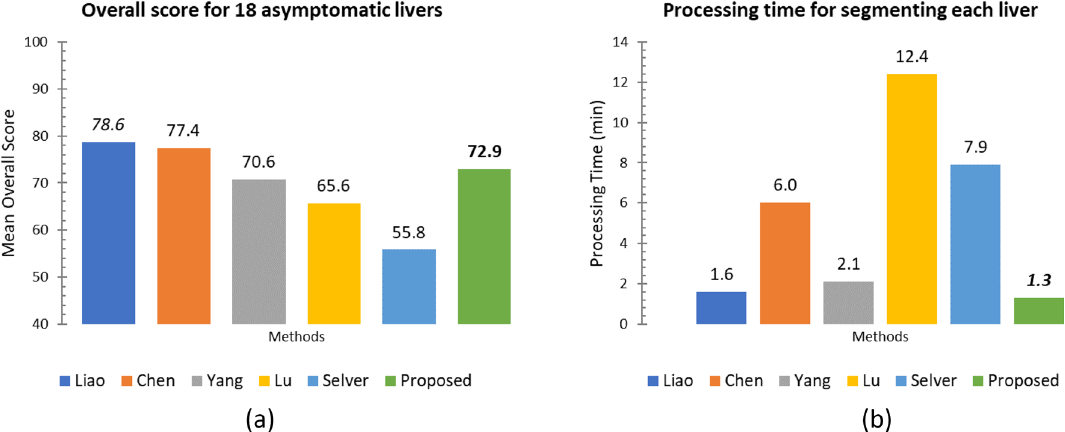
Figure 12. ( a ) Comparisons of the mean overall score among different methods. ( b ) Comparison of the mean processing time among different methods.